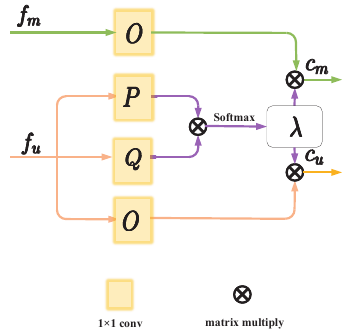
Figure 4. The attention feature fusion module. The module contains three 1 × 1 convolutional layers, O, P, Q, to extract features pixel by pixel.